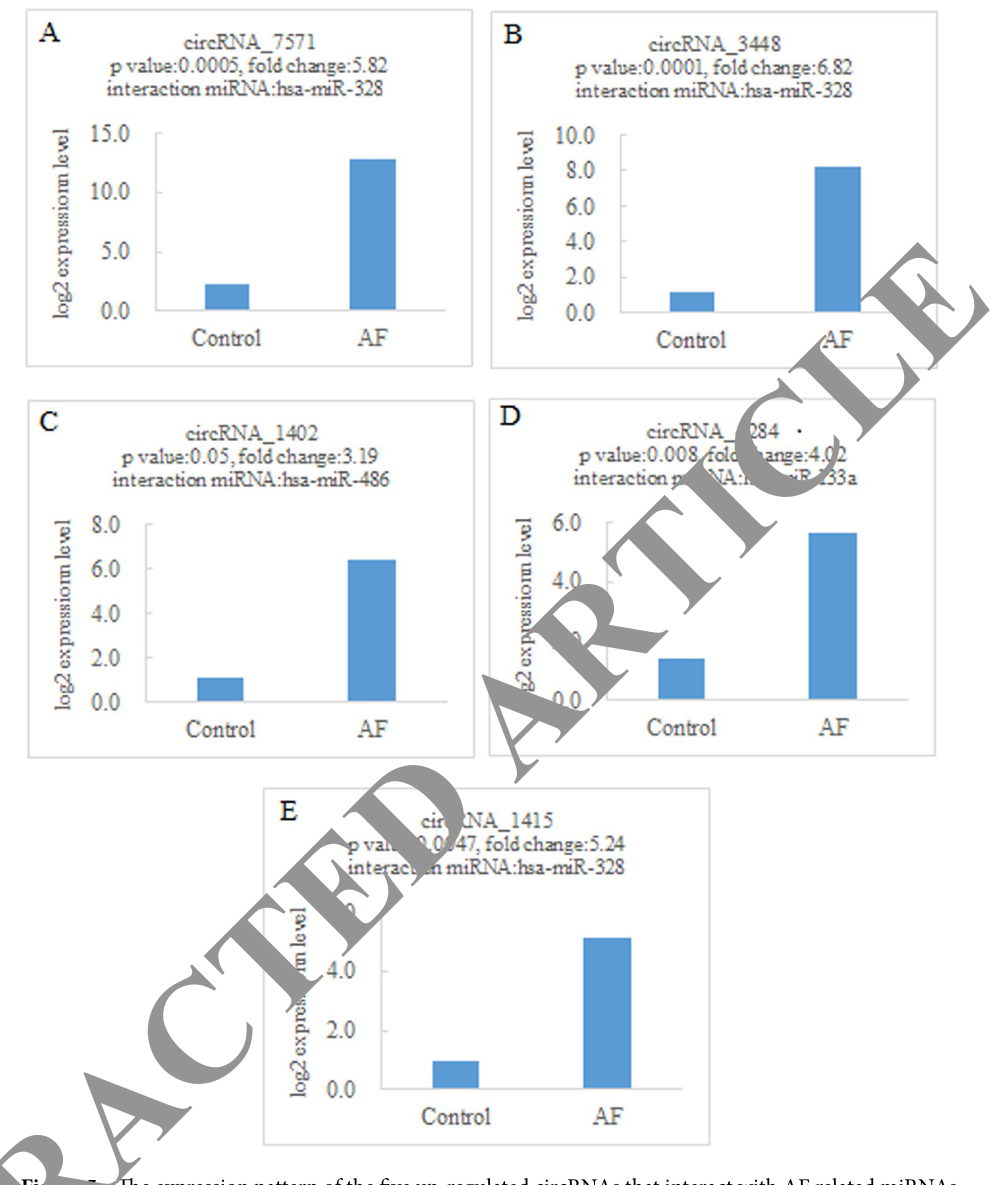
Figure 5. The expression pattern of the five up-regulated circRNAs that interact with AF related miRNAs. ( A ) The expression pattern of hsa_circRNA_7571 that interact with has-miR-133a. ( B ) The expression pattern of hsa_circRNA_3448 that interact with has-miR-328. ( C ) The expression pattern of hsa_circRNA_1402 that interact with has-miR-486. ( D ) The expression pattern of hsa_circRNA_4284 that interact with has-miR-328. ( E ) The expression pattern of hsa_circRNA_1415 that interact with